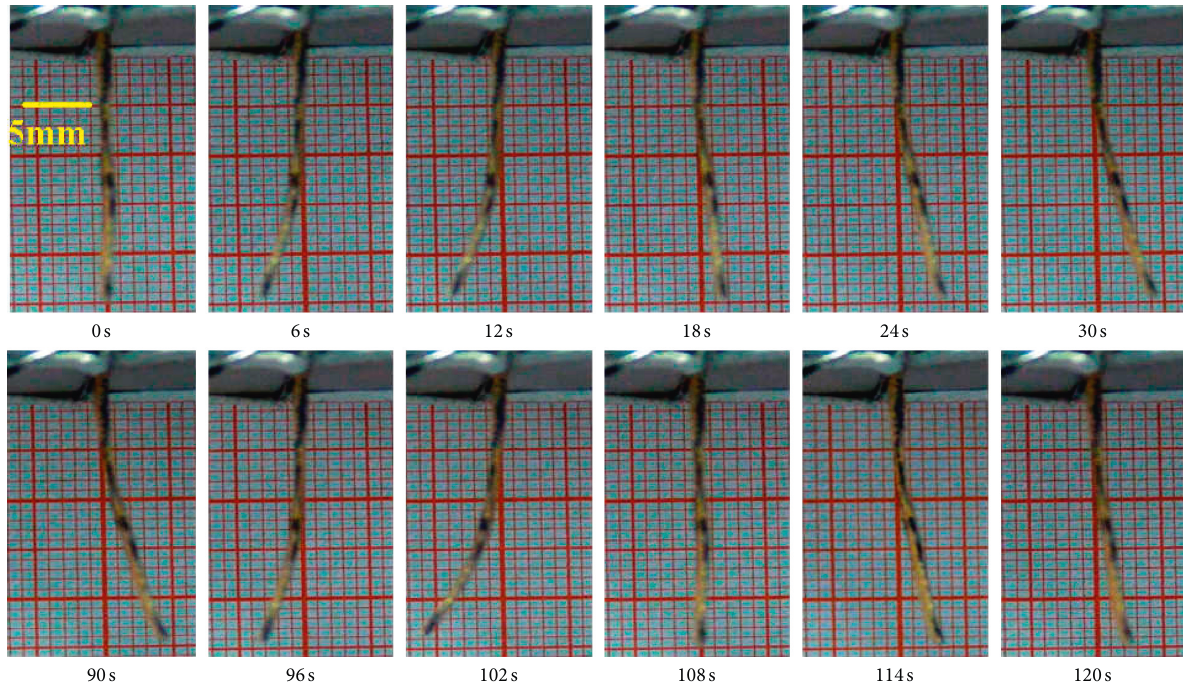
Figure 13: Soft actuator motion screenshots when the input voltage is 4V.